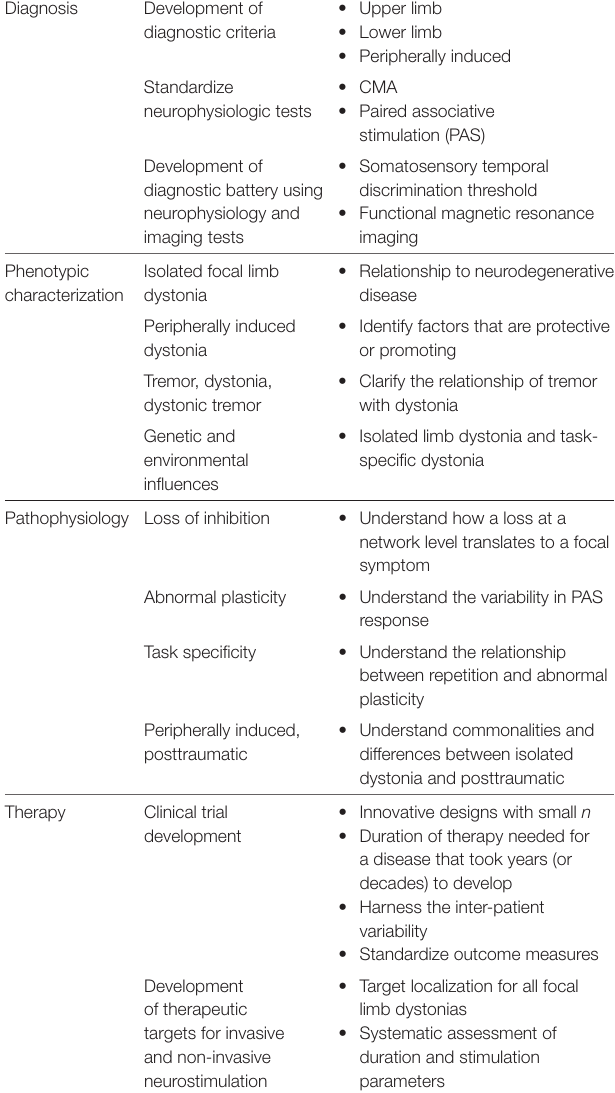
TAbLe 2 | Themes in focal limb dystonia research